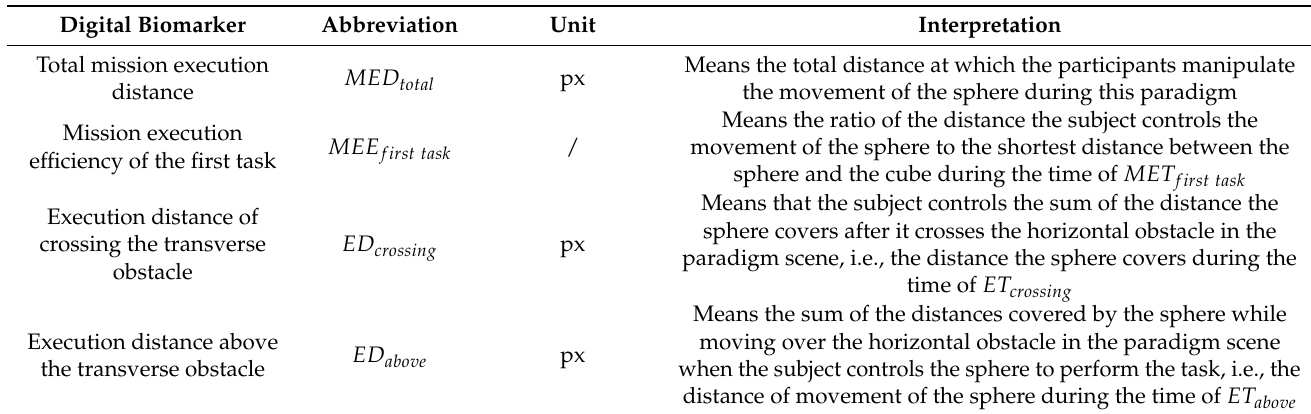
Table 3. Distance-related digital